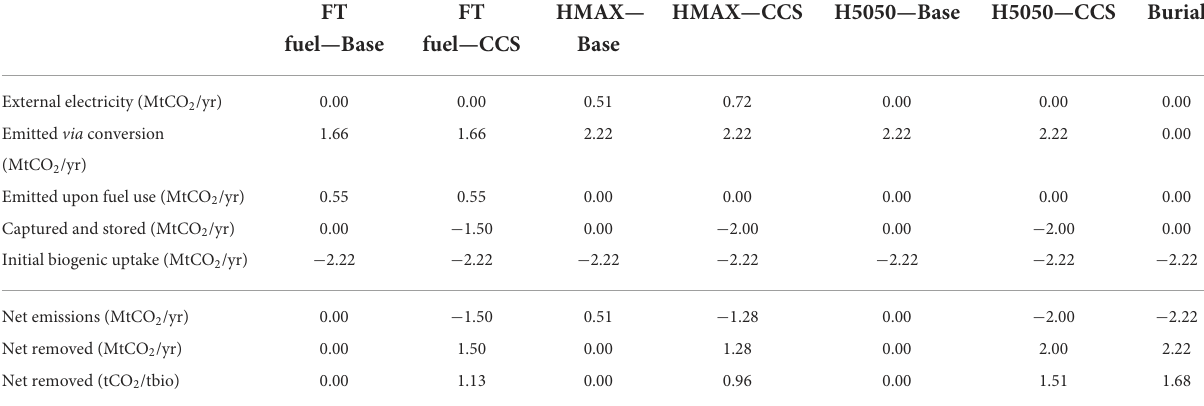
TABLE 7 Carbon balance for Case